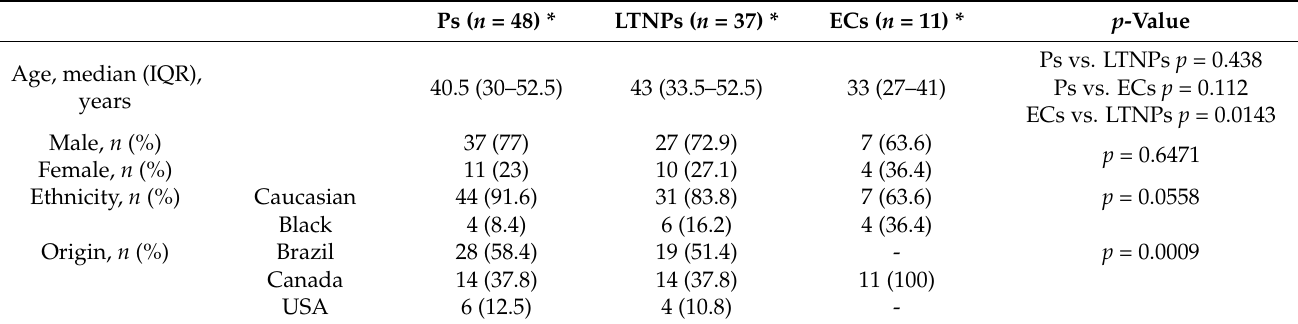
Table 1. General characteristics of the studied patient cohort.